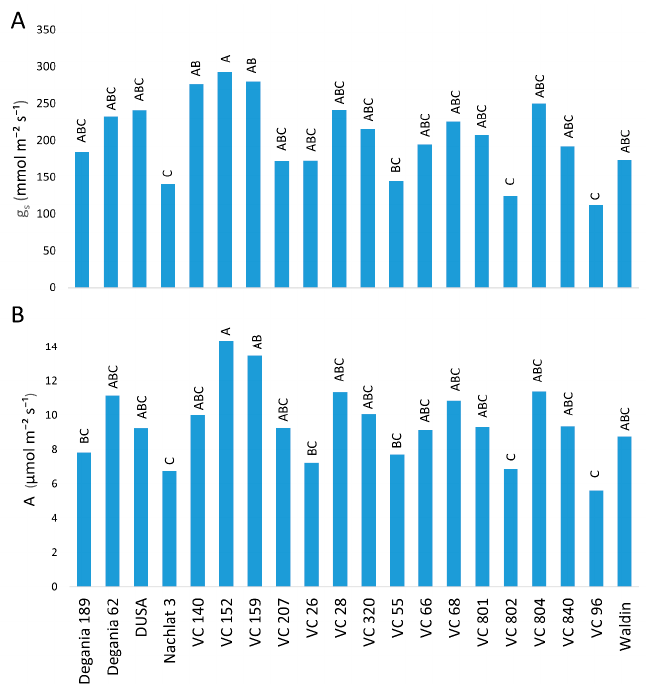
Figure 5. Stomatal conductance ( A ) and CO 2 assimilation ( B ) of ‘Hass’ avocado trees grafted onto various rootstocks, after 18 months of salinity exposure. Different letters represent significant ( p ≤ 0.05) differences between rootstocks. SD values are presented in Table S1. In the NDRE mosaic (Figure 6A), red represents bare soil, yellow to pale green indi- cates stressed plants, and dark green to blue shows vigorous canopy (Figure 6A) (see https://micasense.com/what-is-ndre, accessed on 10 August 2021). We found the highest NDRE values in rootstocks VC 802, Degania 62, and VC 159, and the lowest in VC 840 and Dusa (Figure 6B).